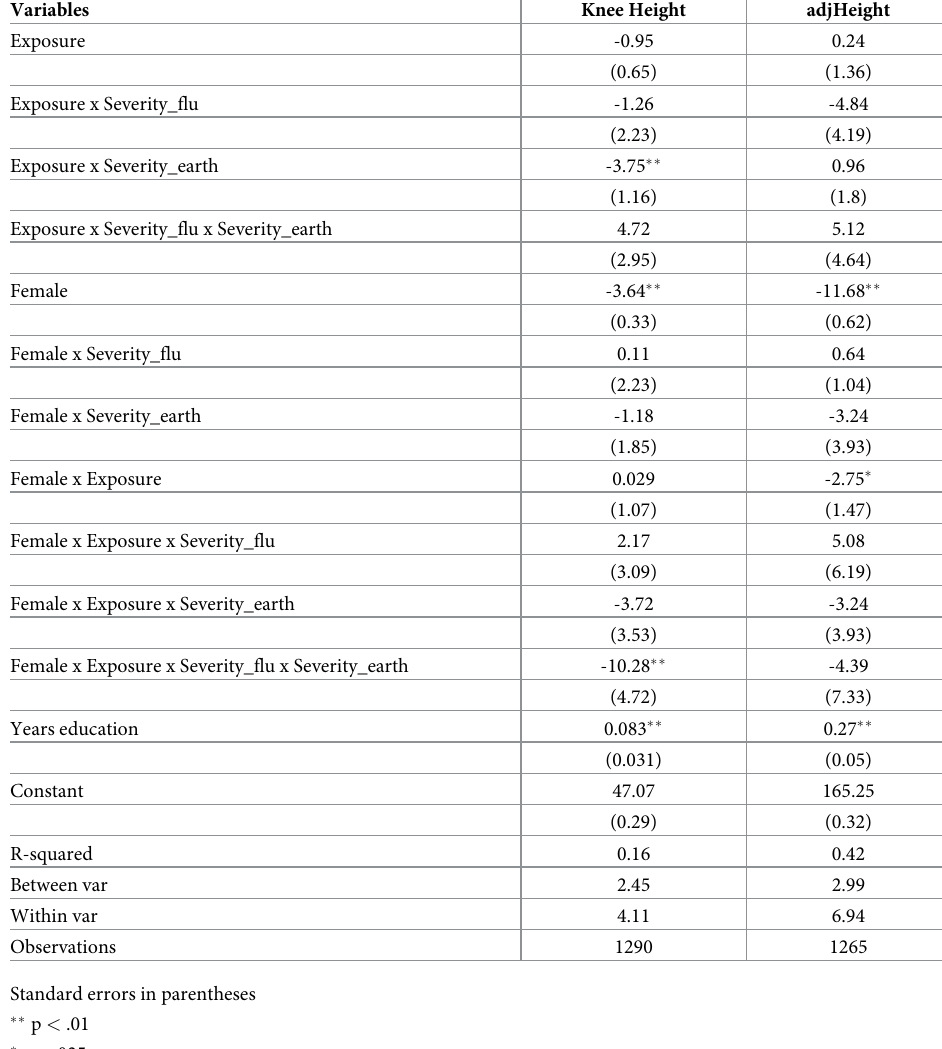
Table 6. Models with flu and earthquake